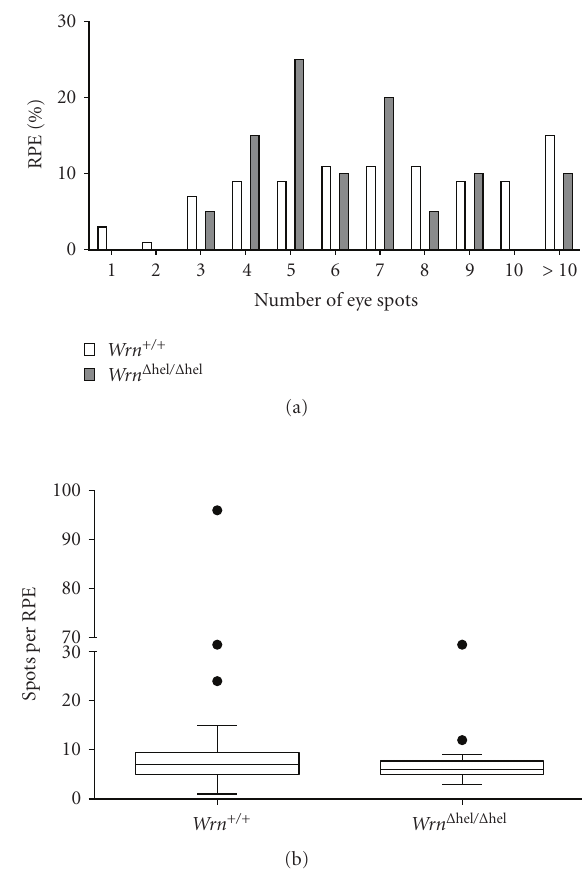
Figure 2: Frequency of HR in mouse RPE. (a) Population distribution of eye spots per RPE in wild-type (open boxes) and Wrn Δ hel / Δ hel (grey boxes). (b) Overall frequency of eye spots per RPE shown as a box and whisker plot. No statistical di ff erence in HR was detected between wild-type and Wrn Δ hel / Δ hel groups ( P = .